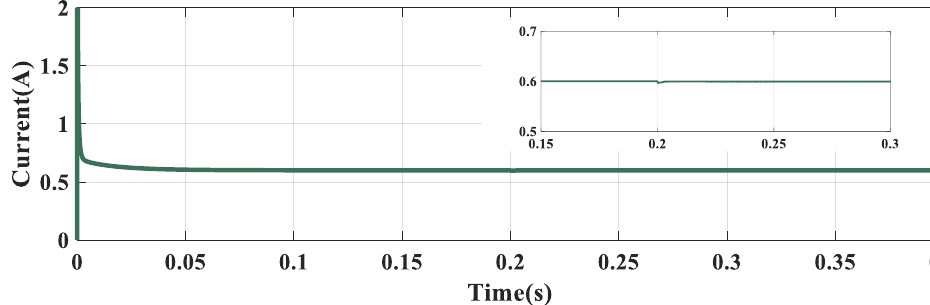
Figure 13. Study 2: Load current.